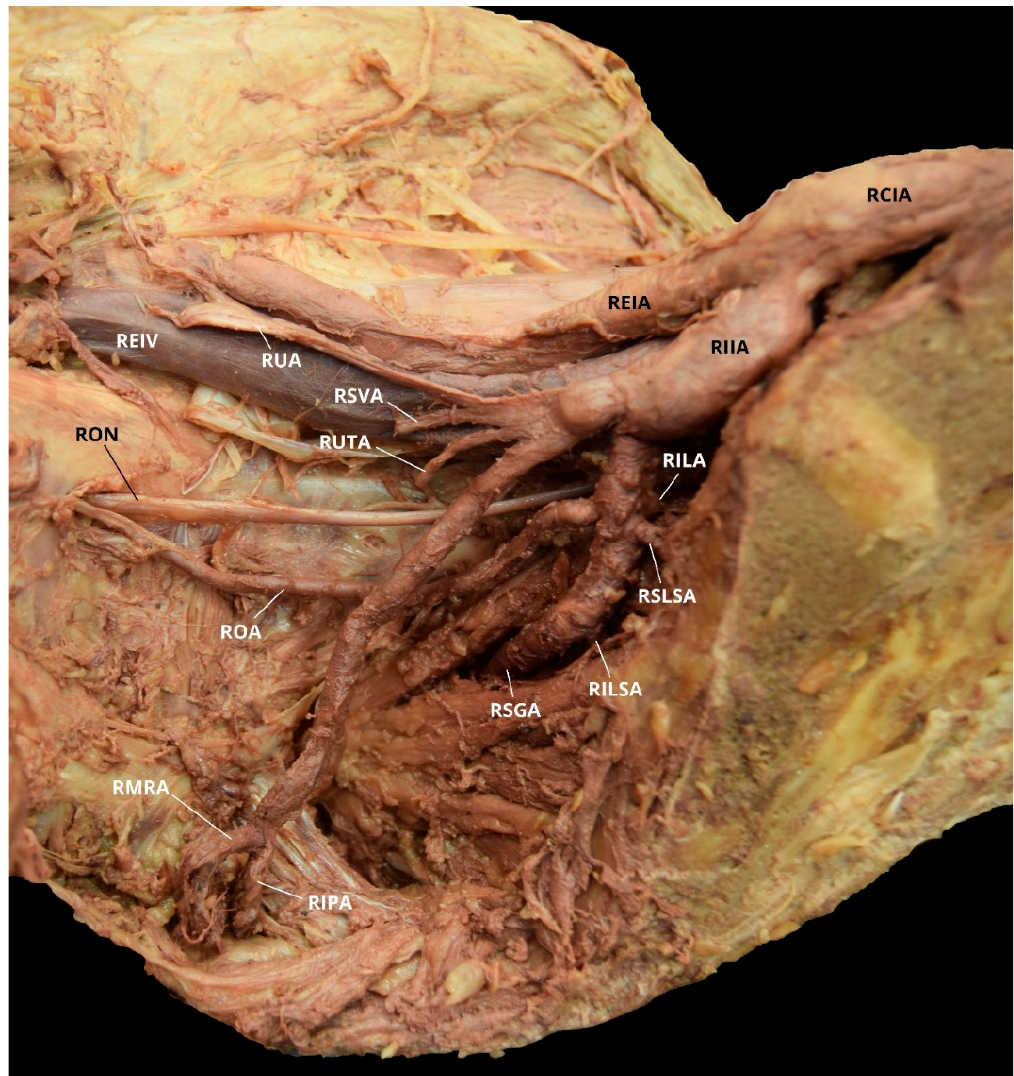
Figure 7. Facilitated display highlighting the right internal iliac artery branches for Case 4. RCIA = Right Common Iliac Artery; REIA = Right External Iliac Artery; REIV = Right External Iliac Vein; RIIA = Right Internal Iliac Artery; RILA = Right Iliolumbar Artery; RILSA = Right Inferior Lateral Sacral Artery; RIPA = Right Internal Pudendal Artery; RMRA = Right Middle Rectal Artery; ROA = Right Obturator Artery; RON = Right Obturator Nerve; RSGA = Right Superior Gluteal Artery; RSLSA = Right Superior Lateral Sacral Artery; RSVA = Right Superior Vesical Artery; RUA = Right Umbilical Artery; RUTA = Right Uterine Artery. The Right Inferior Gluteal Artery (RIGA) and Right Vaginal Artery (RVA) are not pictured.